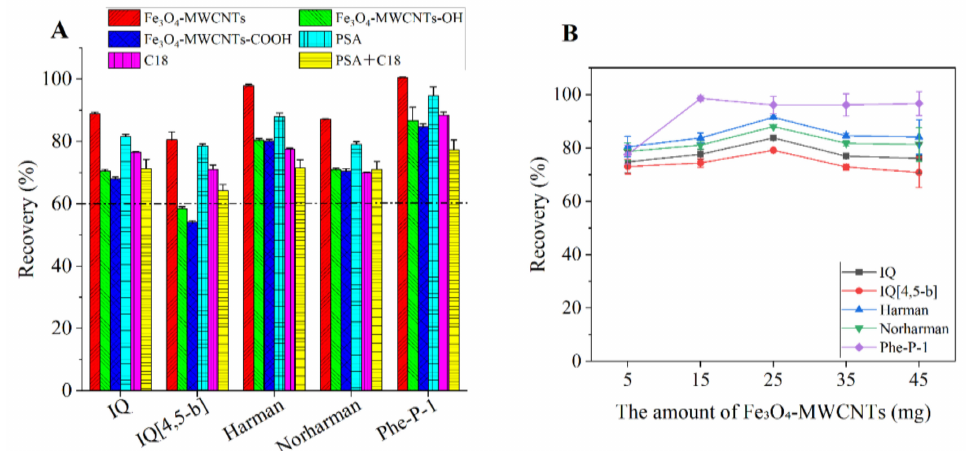
Figure 2. Effects of important factors of the clean-up process on the recovery. ( A ): type of adsorbent; ( B ): amount of Fe 3 O 4 -MWCNTs. Spiked concentration, 300